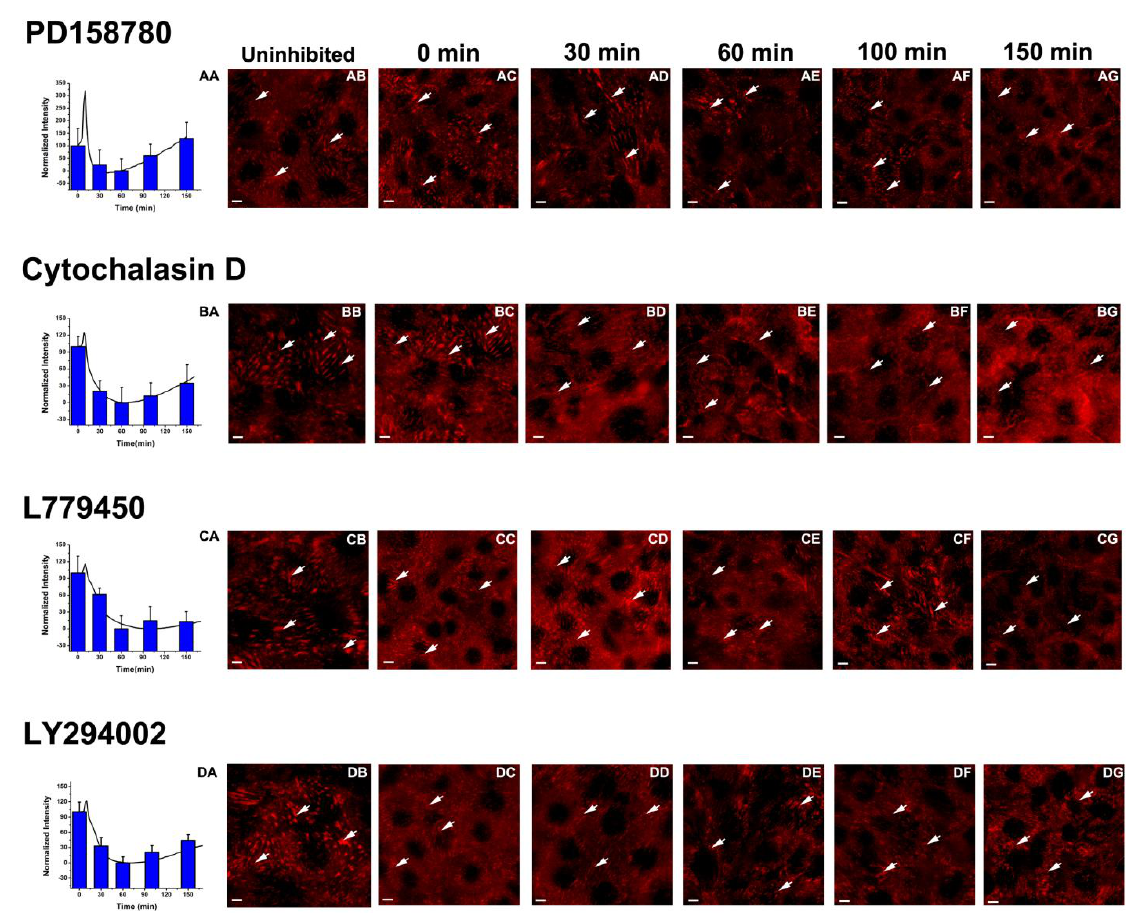
and the level of focal adhesions, and suggesting that the change in cell adhesion, more specifically, the restructuring of focal adhesions can be assessed based on the time-dependent change in Δ D -response. Figure 3. Time dependent relationship between changes in energy dissipation factor and vinculin immunofluorescence staining within focal adhesions of mutant MCF10A cells in response to 10 nM EGF. Examples of focal adhesions are indicated with arrows. Scale bar: 10 µm. The cells had been pretreated with the following inhibitors: 100 nM PD158780 (row A ), 1 µM cytochalasin D (row B ), 10 µM L779450 (row C ), 10 µM LY294002 (row D ), and 5 µM U73122 (row E ). ( AA ), ( BA ), ( CA ), ( DA ), and ( EA ) Quantitation of the areal densities of stained vinculin in relative fluorescence units (RFU) as a measure of focal adhesions (mean ± SEM; n = 10). A strong correlation is shown between the normalized Δ D -response and the normalized RFU of focal adhesions. To ensure that the values of RFU and Δ D could be compared, each of the values was normalized, i.e. , was divided by the range covered. For each quantity, the range was taken as the highest value (at 0 min) minus the lowest value (at 60 min). All correlations are highly statistically significant (p < 0.005). In each of rows (A) to (E), column (B) shows the fluorescence images of focal adhesions in a monolayer of cells prior to inhibition, labeled as uninhibited. Columns (C) to (G) show the fluorescence images of focal adhesions in a monolayer of cells after being exposed first to the inhibitor for 40 min, then to 10 nM EGF for: ( C ) 0 min, ( D ) 30 min, ( E ) 60 min, and ( F ) 100 min, and ( G ) 150